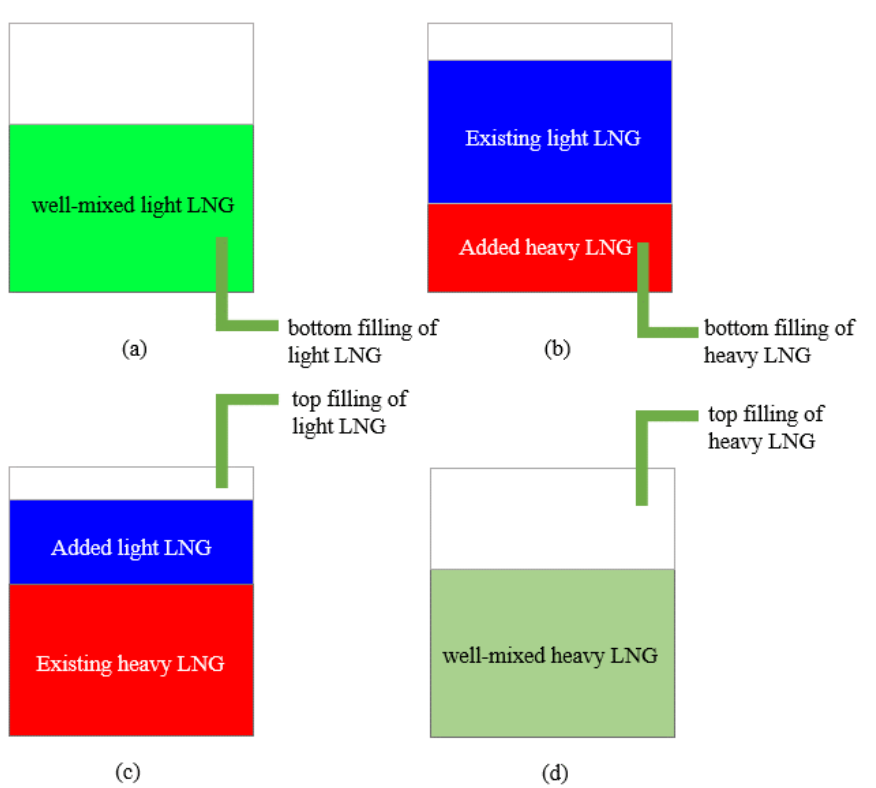
Figure 4. Density contours after 7 h of filling operation for a density difference of 2.5 kg/m 3 between the heel and refilled LNG for ( a ) bottom filling of light LNG, ( b ) bottom filling of heavy LNG, ( c ) top filling of light LNG, and ( d ) top filling of heavy LNG. This figure is adapted from [72]. The experimental results were recreated using numerical simulations by Wang et al.